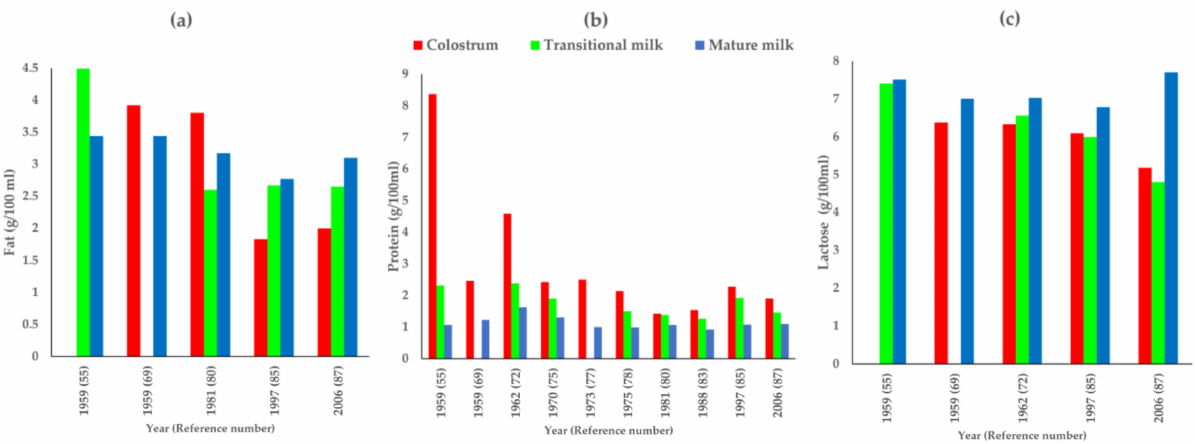
Figure 4. Studies reporting ( a ) fat (g/100 mL), ( b ) protein (g/100 mL) and ( c ) lactose (g/100 mL) for at least two stages of